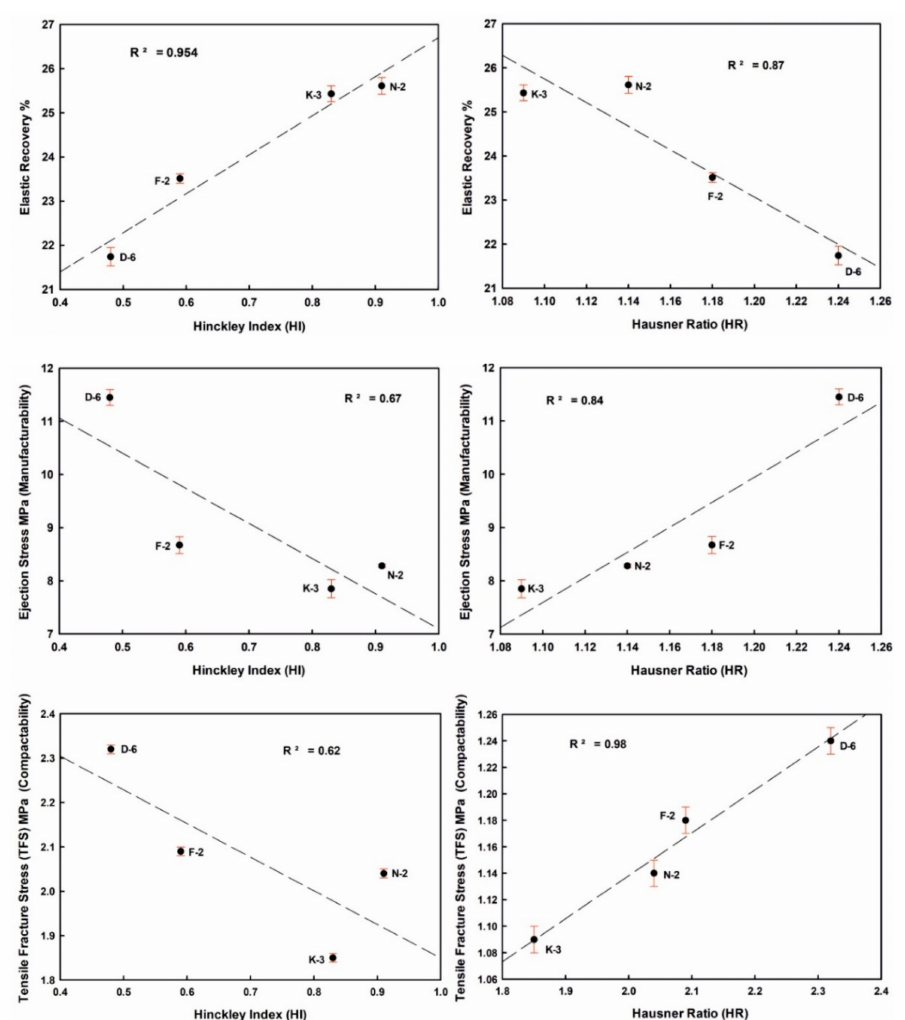
Figure 11. Influence of kaolinite crystallinity (HI) and flowability (HR) on the tableting properties of the studied kaolin powder